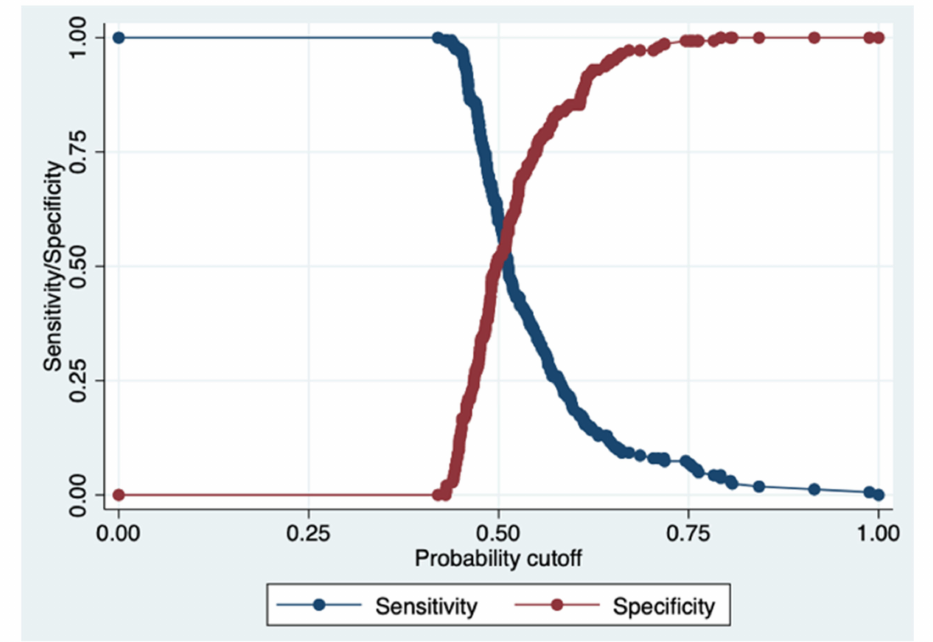
Figure 4. Plot of sensitivity/specificity versus probability cut-off point. This post-estimation, i.e., the sensitivity/specificity versus probability cut-off plot, indicates that at a probability cut-off of 0.50, both the sensitivity and specificity for the triglycerides/HDL ratio are satisfactory. In fact, the two lines (red and blue) merge at a level superior to 50%, indicating a sufficient discrimination power (see details in Table